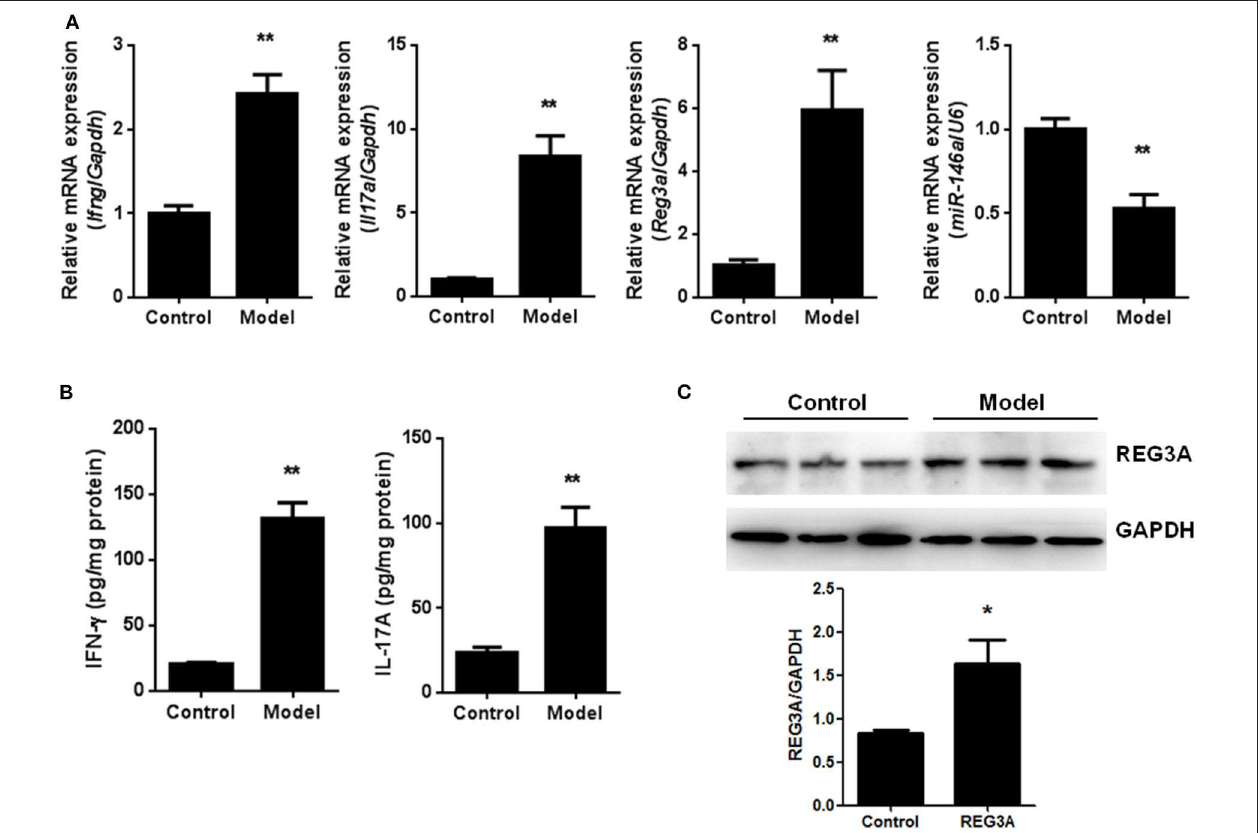
FIGURE 2 | The levels of regenerating islet-derived protein 3-alpha (REG3A) and miR-146a in an experimental autoimmune myositis (EAM) model. (A) The messenger RNA (mRNA) expression of interferon gamma (IFN- γ ), interleukin (IL)-17A, REG3A, and miRNA-146a in muscle tissues were determined by real-time PCR. The relative mRNA expression was normalized using glyceraldehyde 3-phosphate dehydrogenase (GAPDH)/U6. ( n = 9) (B) . The levels of IFN- γ Fand IL-17A in serum from the EAM mice were determined by ELISA assay ( n = 9). (C) The protein levels of REG3A in muscle tissues were determined by Western blot ( n = 3). GAPDH was used as the internal controls for Western blot analysis. Bands were quantified using ImageJ. Data are shown as means ± SEM. * p < 0.05, ** p < 0.01 in comparison with the control